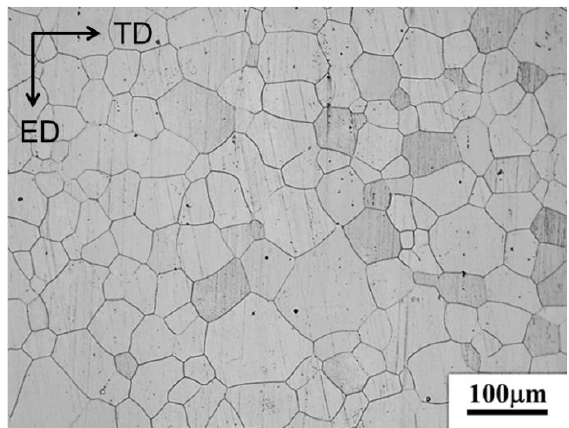
Figure 1. Optical microstructure of the initial alloy.